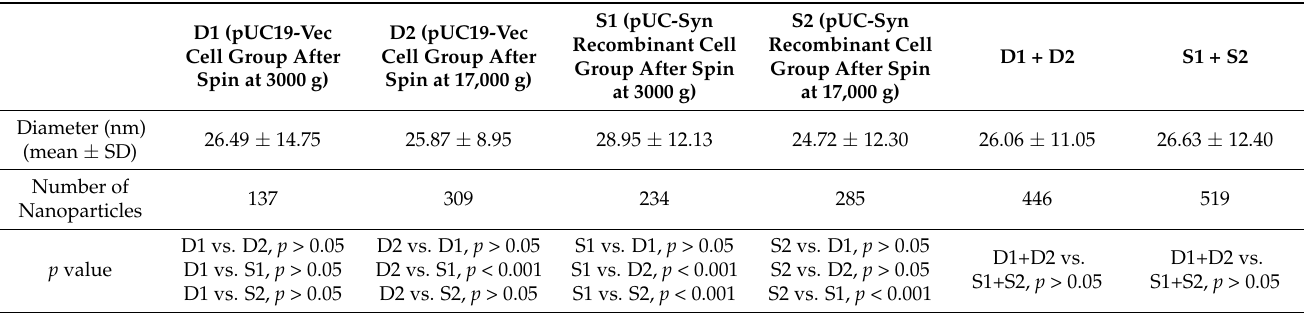
Table 1. Comparison of nanoparticle